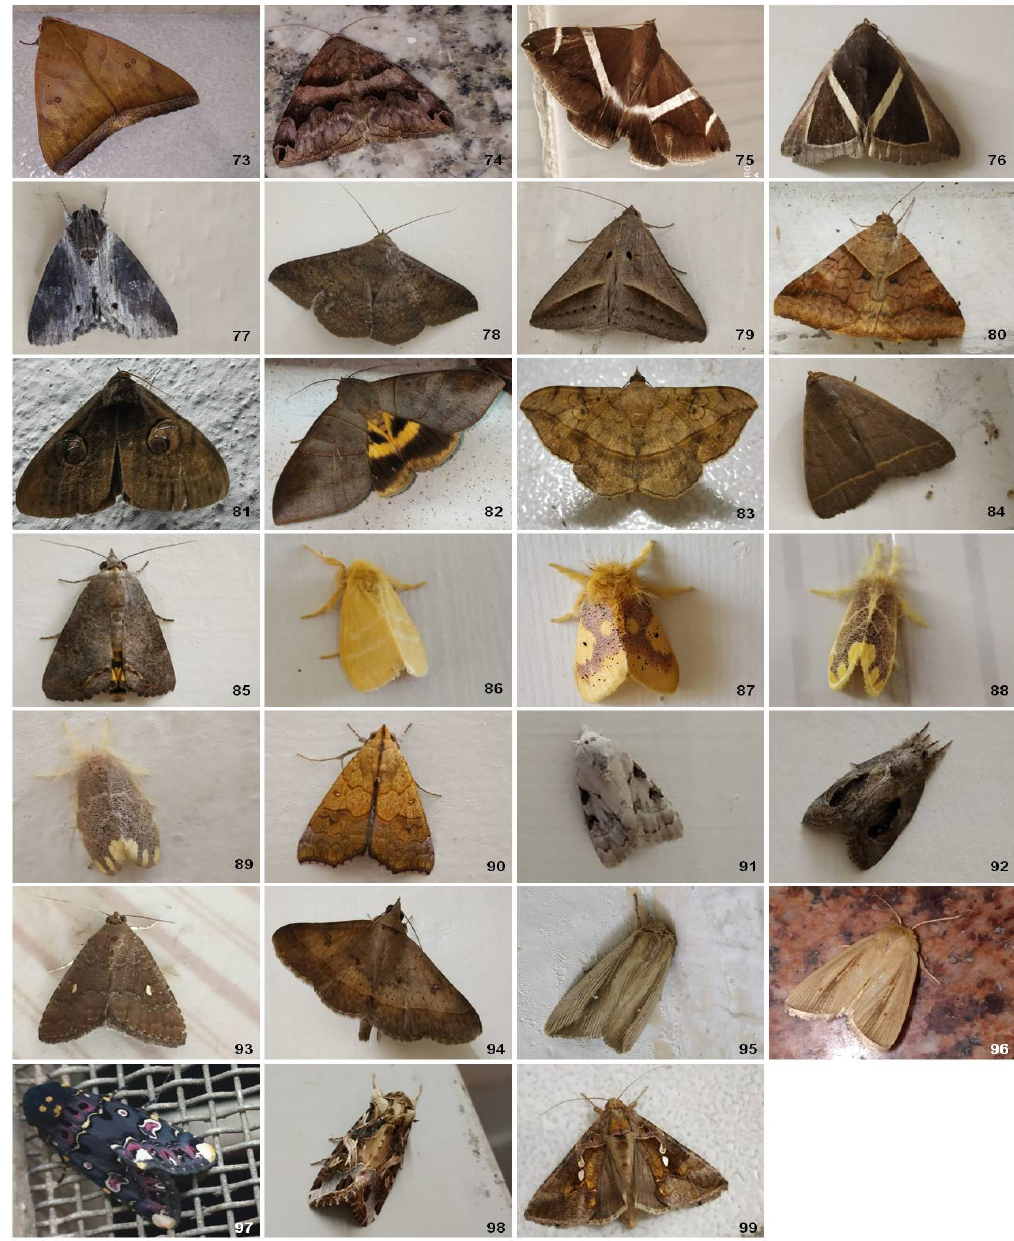
Plate 4. 73– Artena dotata ; 74– Bastilla angularis ; 75– Bastilla arctotaenia ; 76– Chalciope mygdon ; 77– Ercheia cyllaria ; 78– Ericeia inangulata ; 79– Mocis frugalis ; 80– Mocis undata ; 81– Spirama cf. retorta ; 82– Thyas coronata ; 83– Anticarsia irrorata ; 84– Simplicia sp.; 85– Hypocala sp.; 86– Euproctis sp.; 87– Nygmia icilia; 88– Orvasca sp.; 89– Somena sp.; 90– Anomis flava ; 91–Nola analis; 92–Selepa celtis; 93–Condica sp.; 94–Helicoverpa sp.; 95–Leucania loreyi; 96– Leucania sp.; 97– Polytela gloriosae ; 98– Spodoptera litura ; 99– Ctenoplusia agnata